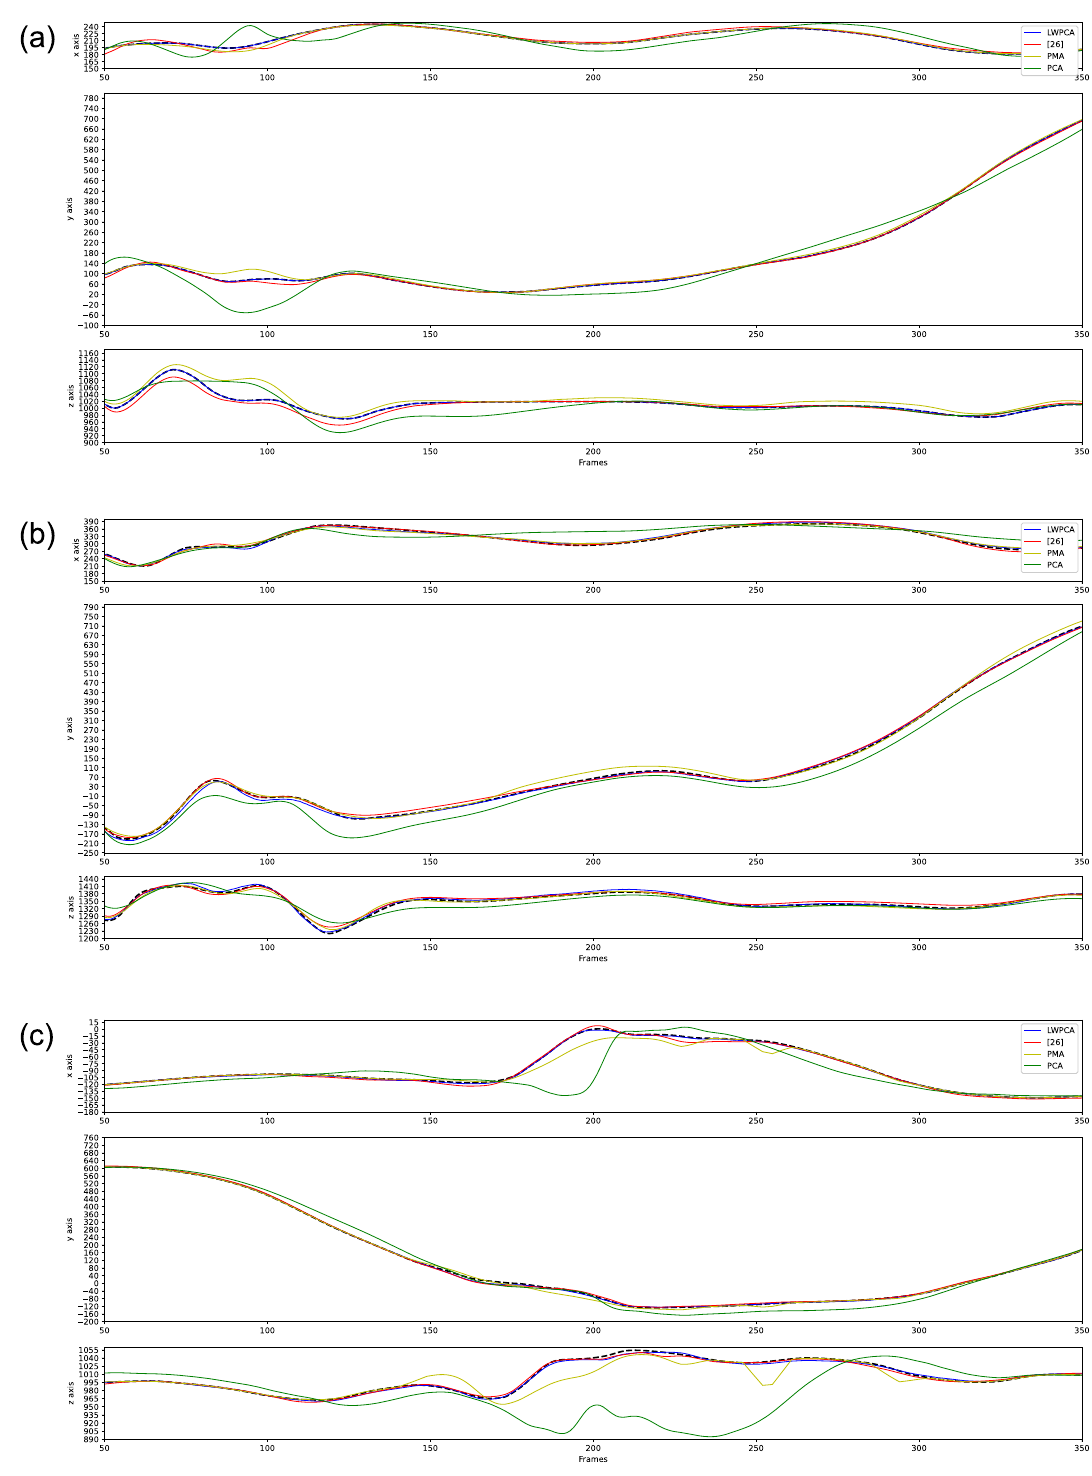
PLOS ONE | https://doi.org/10.1371/journal.pone.0272407 August 8,